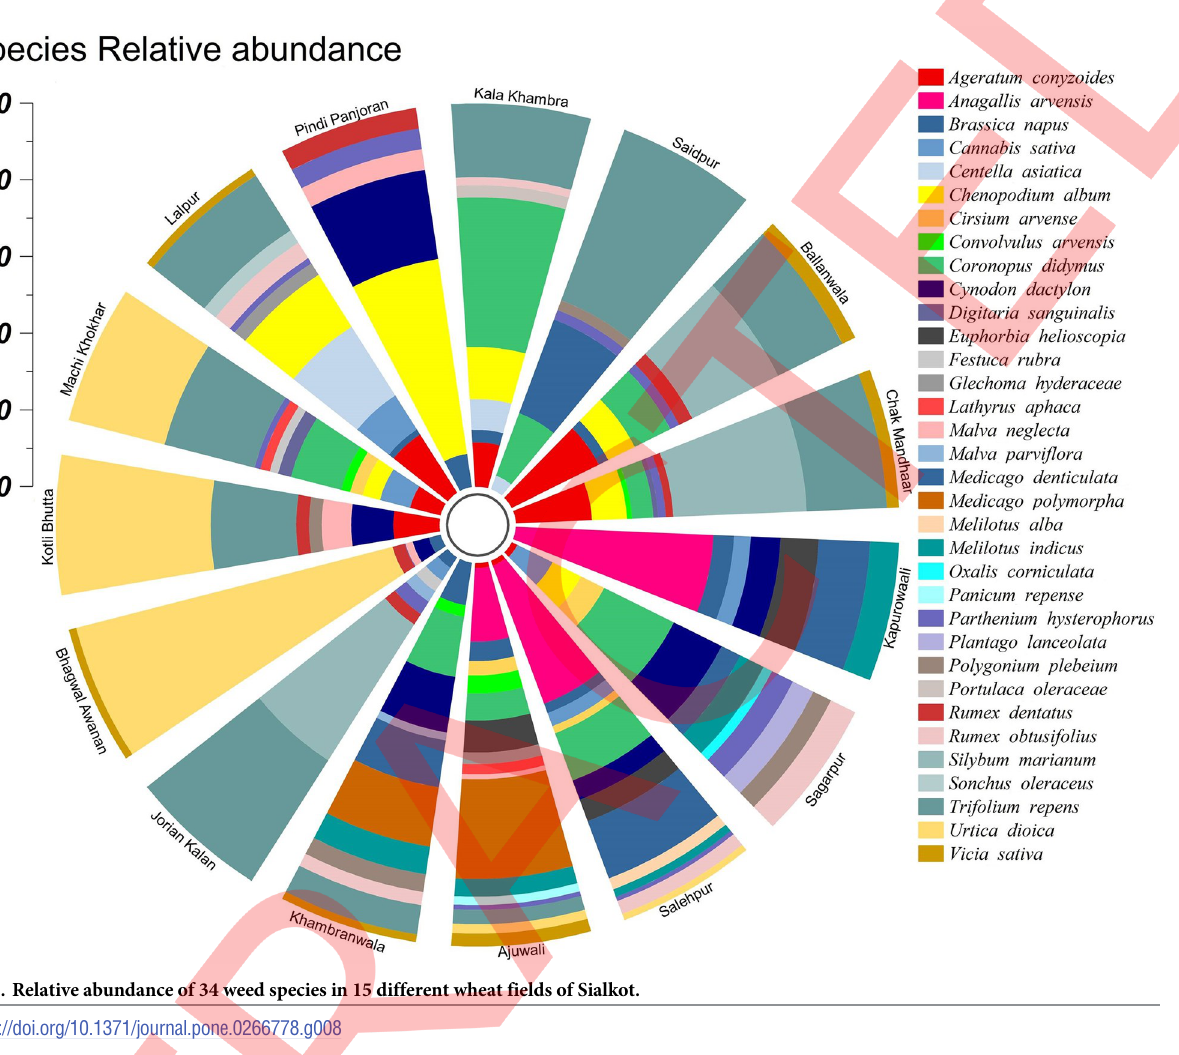
Fig 8. Relative abundance of 34 weed species in 15 different wheat fields of